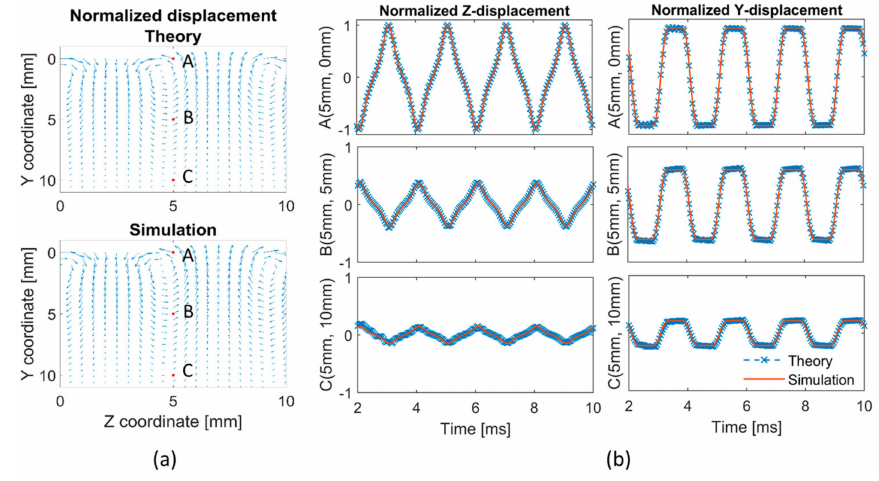
Figure 3. Comparison of theoretical and simulation results: ( a ) vector plots demonstrating normalized displacements, ( b ) z and y components of the displacement at the position z = 5 mm for depths y = 0, 5 and 10 mm. Note that simulated displacements of the finite element (FE) grid (mesh size of 0.2 mm) were interpolated to a coarser spatial grid for visualization